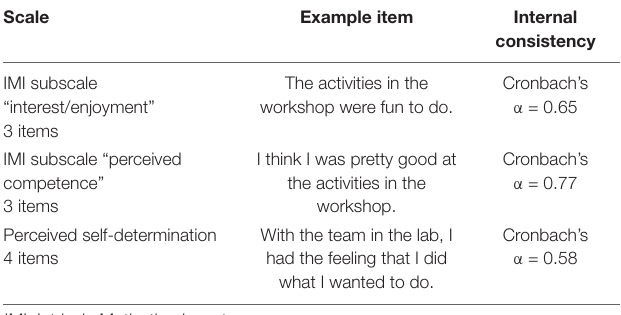
TABLE 2 | Applied test instruments with example item and internal consistency.